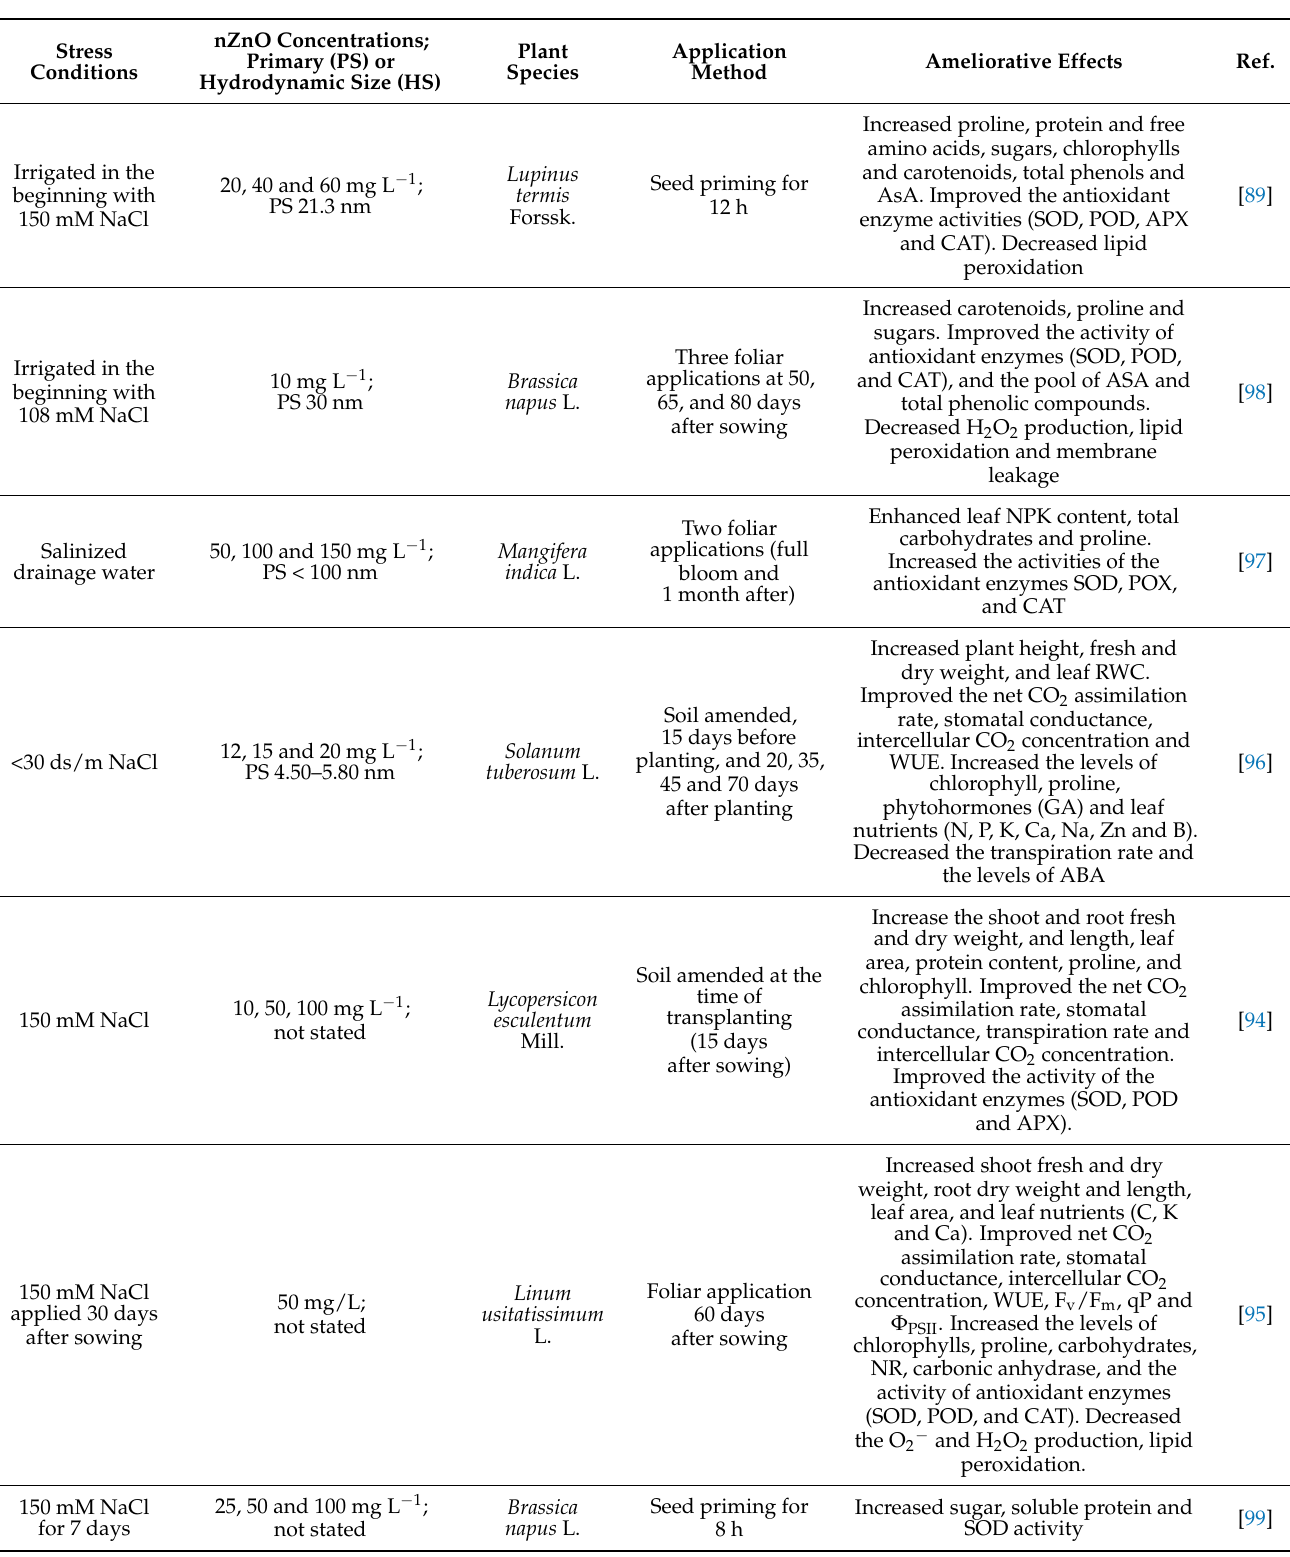
Table 4. Effects of nZnO on plants under salinity